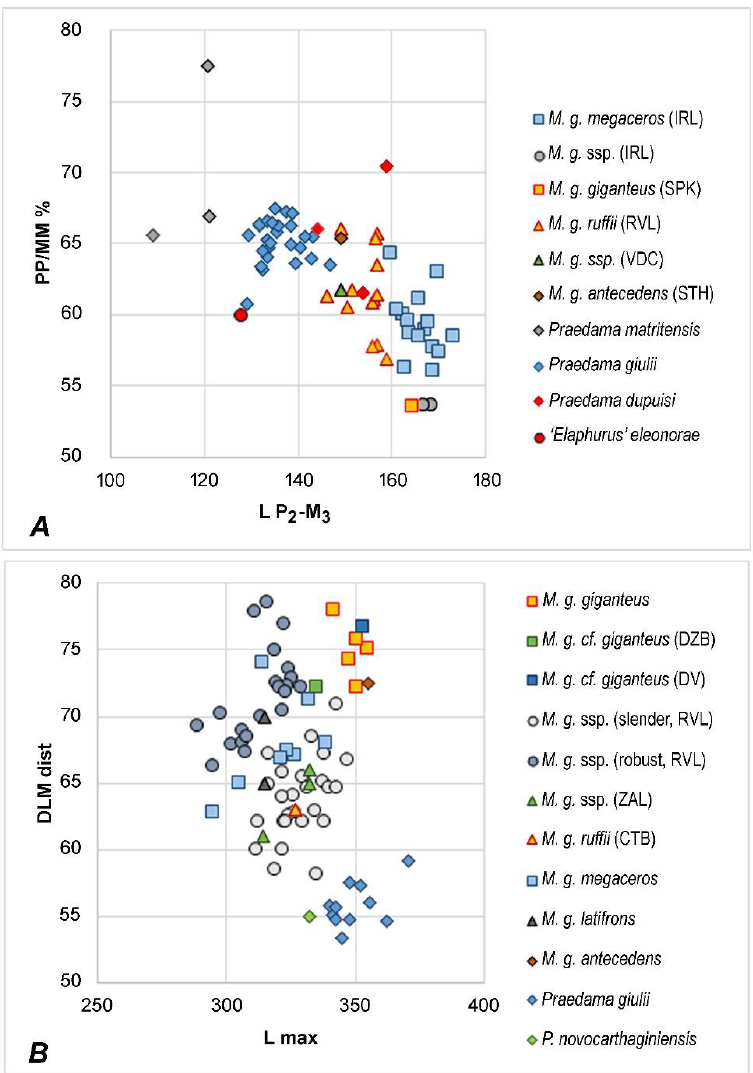
Figure 5. Scatter diagrams showing the size and proportions of lower cheek teeth ( A ) and metacarpals ( B ) of various forms and subspecies of M. giganteus compared to Praedama and “ Elaphurus ” eleonorae . The data on giant deer from Ireland are adapted from Croitor et al. [29]; the data on giant deer from Rhine Valley are adapted from van der Made [27]; the data on giant deer metacarpals from Zhana-Aul are adapted from Kozhamkulova [67]; the data on Praedama giulii are adapted from Kahlke [68]; the data on P. novocarthaginiensis , P. matritensis and “ Elaphurus ” eleonorae are adapted from van der Made [56,69] and Vislobokova [70] respectively. Abbreviations: IRL, Ire- land; SPK, Sapozhok; RVL, Rhine Valley; VDC, Val di Chiana; STH, Steinheim; DZB, Dzhambul; DV, Duruitoarea Veche; ZAL, Zhana-Aul; CTB, Cottbus. The specimen from Sapozhok is characterized by the long robust type of metacar- pals that are grouped on the scatter diagram together with the long metacarpals from Western Europe (Figure 5B). Therefore, one can assume that the long robust metacarpals from Ireland should be ascribed to M. giganteus giganteus . The specimen from the Late Pleistocene of Schlutup near Lübeck (Germany) is also characterized by extremely long and robust metacarpal (L = 351 mm; distal mediolateral diameter, DLM, = 75.8 mm [71]) and therefore is ascribed here to M. giganteus giganteus . This form of giant deer was re- ported by van der Made [27] as the “intermediate type” ( M. giganteus irlandicus ) since its